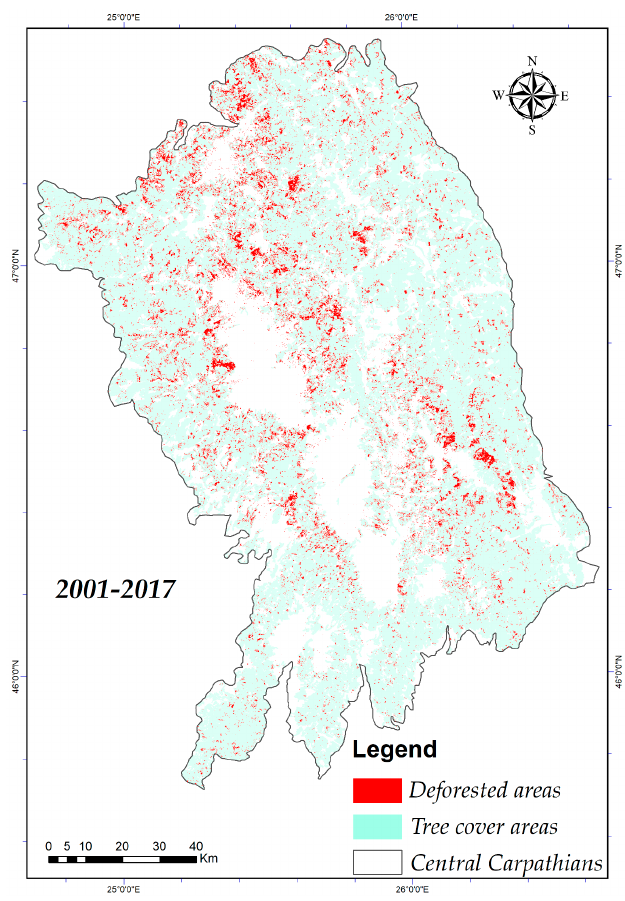
Figure 4. Deforestation in Central Carpathians. The red patches mark the deforested areas meanwhile with green mark the forest areas.